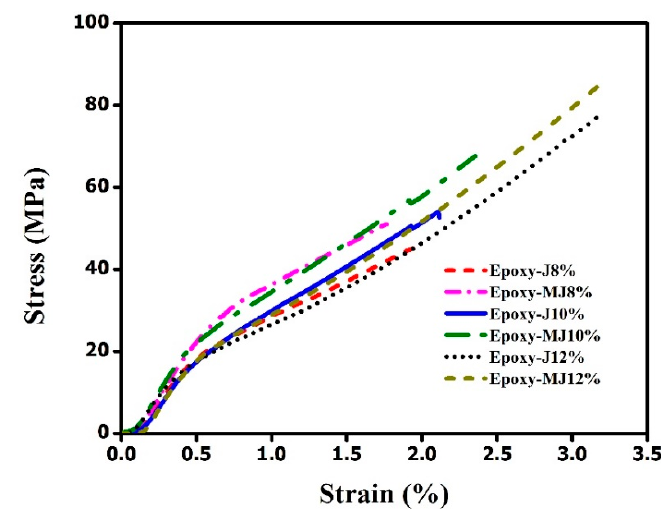
Figure 5. Stress-strain curves of the jute fiber composites with different fiber contents.